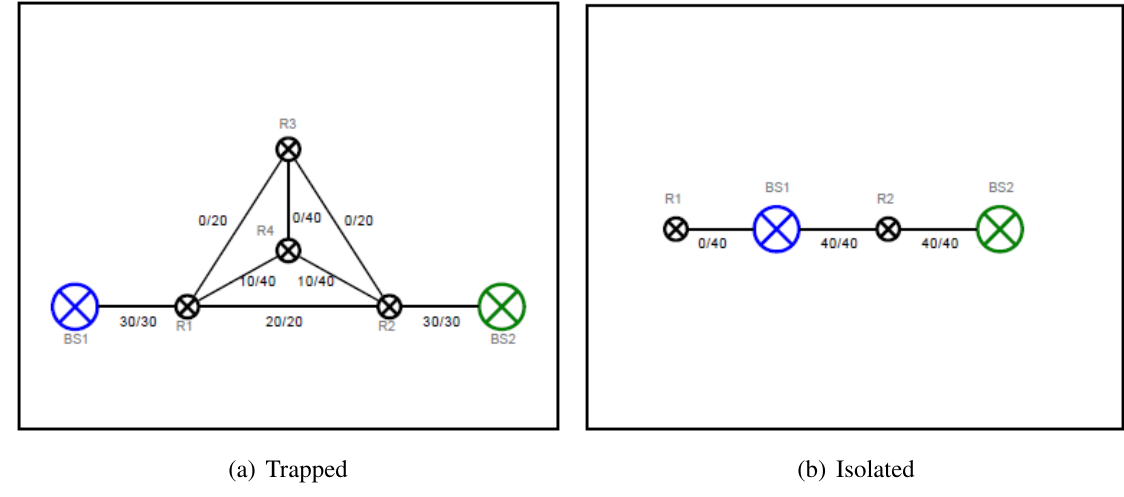
Figure 4. Case studies of local minima.